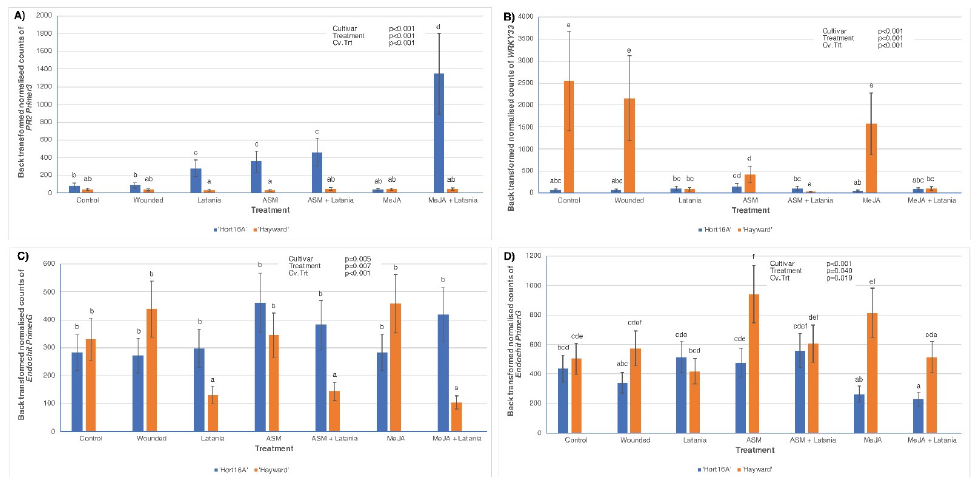
Figure 6. Defence gene expression measured by PlexSet ® NanoString in ‘Hort16A’ and ‘Hayward’ kiwifruit leaf tissue, in 2018, of salicylic acid (SA) pathway-related genes: PR2 Primer3 , at two days post scale infestation (psi), in ( A ); WRKY33 , at two days psi in ( B ), and Endochitinase ( Endochit PrimerG ), at two and seven days psi, in ( C ) and ( D ) respectively. Treatments are described in full in Figure 2. Although leaves were sampled from both two and seven days psi for gene expression measurements, only the statistically significant cultivar × treatment interactions (Cv.Trt) are presented. There were five replicate plants per treatment. The Y-axis represents physical counts of the number of molecules expressed. Statistical analysis necessitated a log 2 transformation, but data are presented as back-transformed means ± standard errors. The Y-axis scale is different for each gene. P-values from ANOVA are shown in the top right-hand corner of each bar chart. Different lettering indicates statistically significant treatment differences, as shown by LSD, p ≤ 0.05.